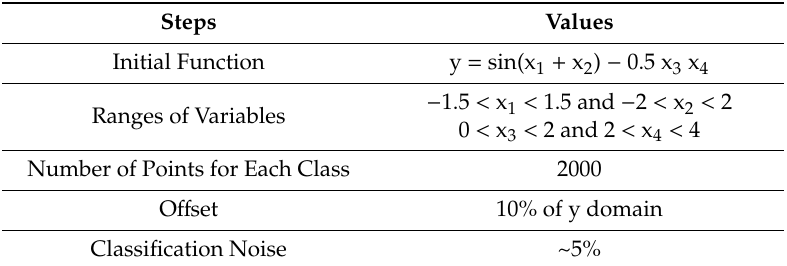
Table A1. Settings for testing SVM–GP on a five-dimensional synthetic database.